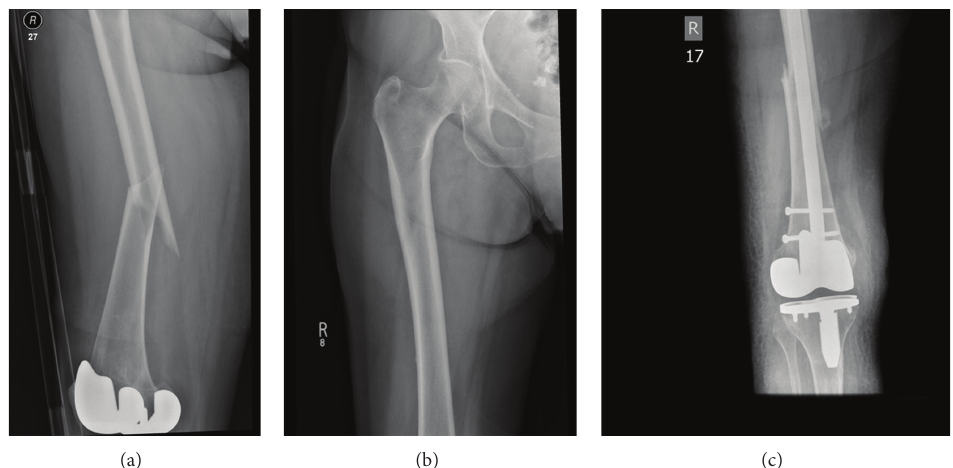
Figure 1: (a) Admission radiograph showing noncomminuted fracture with medial spike. (b) Radiograph taken 4 weeks prior to admission revealing subtle periosteal reaction on lateral cortex. (c) Radiograph 12 days postoperative